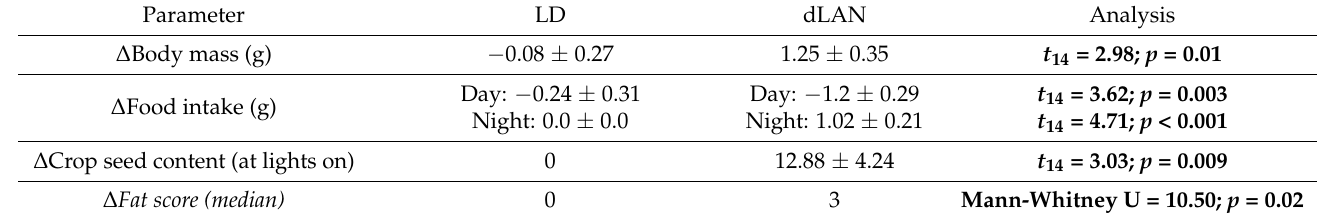
Table 1. Comparison of body physiology and daily behaviors in male zebra finches ( Taeniopygia guttata ) under Light: Dark, LD (12L:12D; L = 200 ± 10 lux, D < 0.1 lux) and dim light at night, dLAN (12L:12dLAN; L = 200 ± 10 lux, dLAN = 5 ± 1 lux) light condition. Values are presented in mean ± SEM unless specified. Parametric Student’s t test and non-parametric Mann-Whitney test compared the light conditions. Bold and unbold values represent presence and absence of significance. Alpha was set at 0.05 for